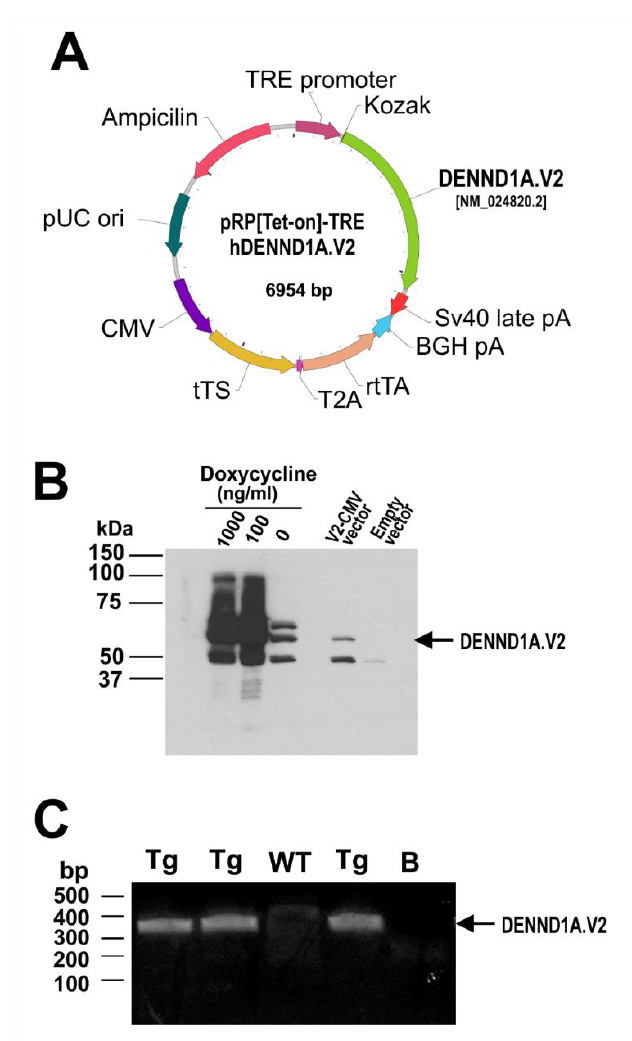
Figure 9. The pRP[Tet-on]-TRE-hDENND1A.V2 expression construct. ( A ) Map of the pRP[Tet-on]- TRE-hDENND1A.V2 vector. ( B ) Efficiency of the construct was tested by Western blot and immunodetection of extracts of transfected CHO cells using an anti-human DENND1A.V2 rabbit antibody. Cells transfected with the pRP[Tet-on]-TRE-hDENND1A.V2 vector were treated with 1000, 100, and 0 ng/mL of doxycycline for 48 h. The pCMV-BAM-hDENND1A.V2 vector was used as the positive control. ( C ) Representative PCR results for the genotyping of wild-type and transgenic mice generated using the pRP[Tet-on]-TRE-hDENND1A.V2 vector. WT, wild-type; Tg, transgenic; B, blank; V2.CMV, pCMV-BAM-hDENND1A.V2 vector.